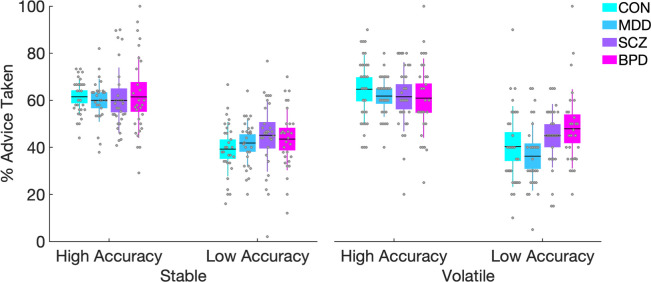
Behavioral results with regard to advice taking.All participants followed the advice significantly more during phases of high compared to low accuracy. The descriptive data shows a trend of BPD patients to follow the advice more during volatile phases of low accuracy (right most plot) but the interaction was not significant. Means are plotted with boxes marking 95% confidence intervals and vertical lines showing standard deviations.